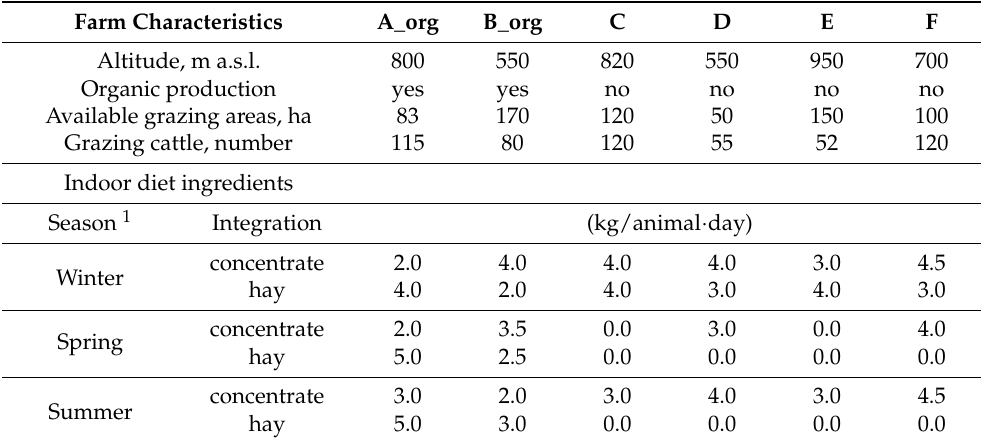
Table 1. Farm characteristics and diet formulation; in square bracket unit